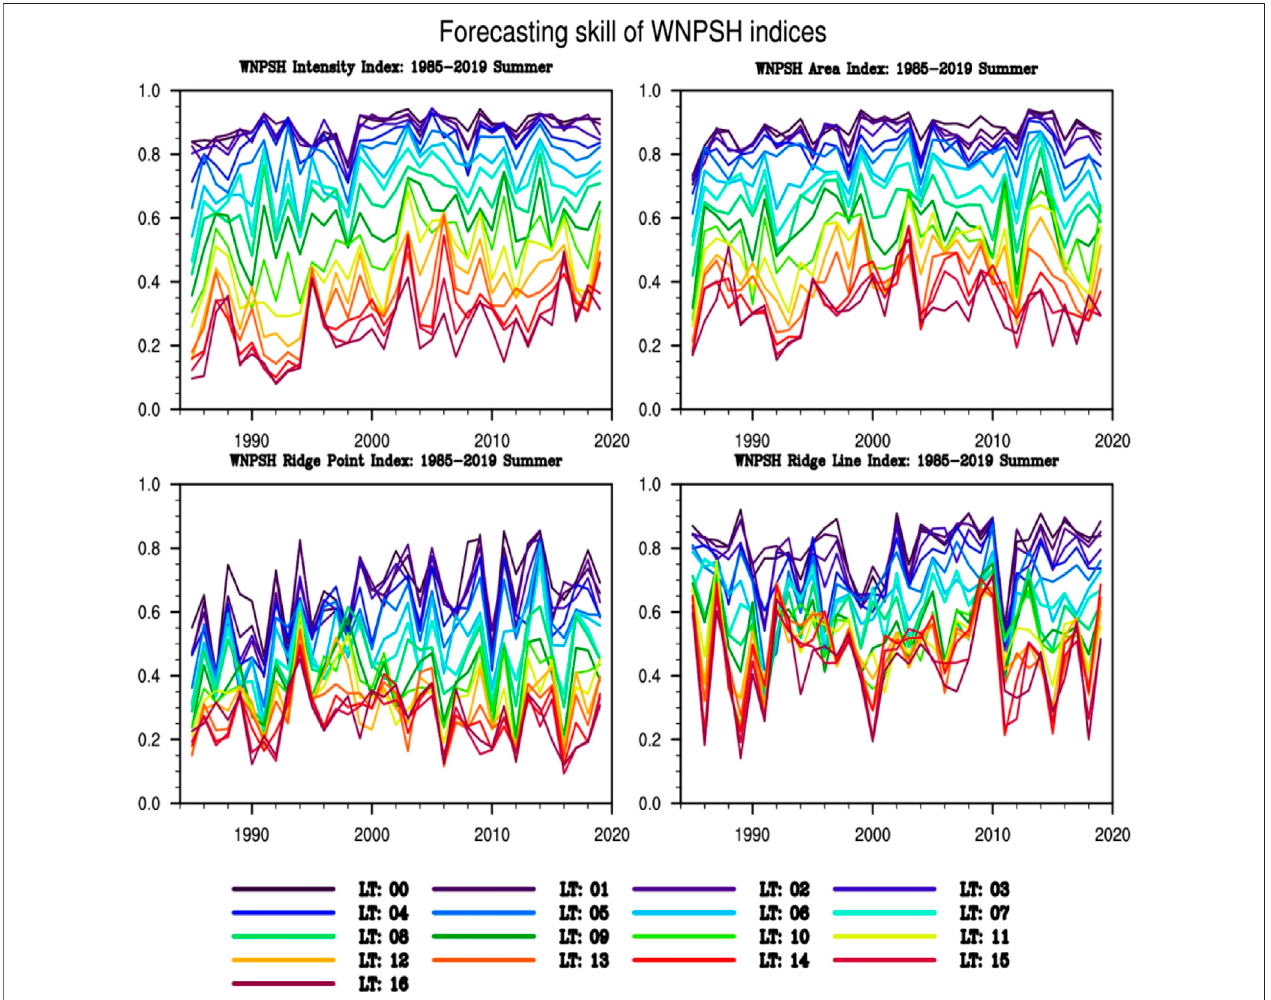
FIGURE 7 | Yearly variations in prediction skills of the summer WNPSH indices (A – D) represent intensity, area, ridge point, and ridge line, respectively.